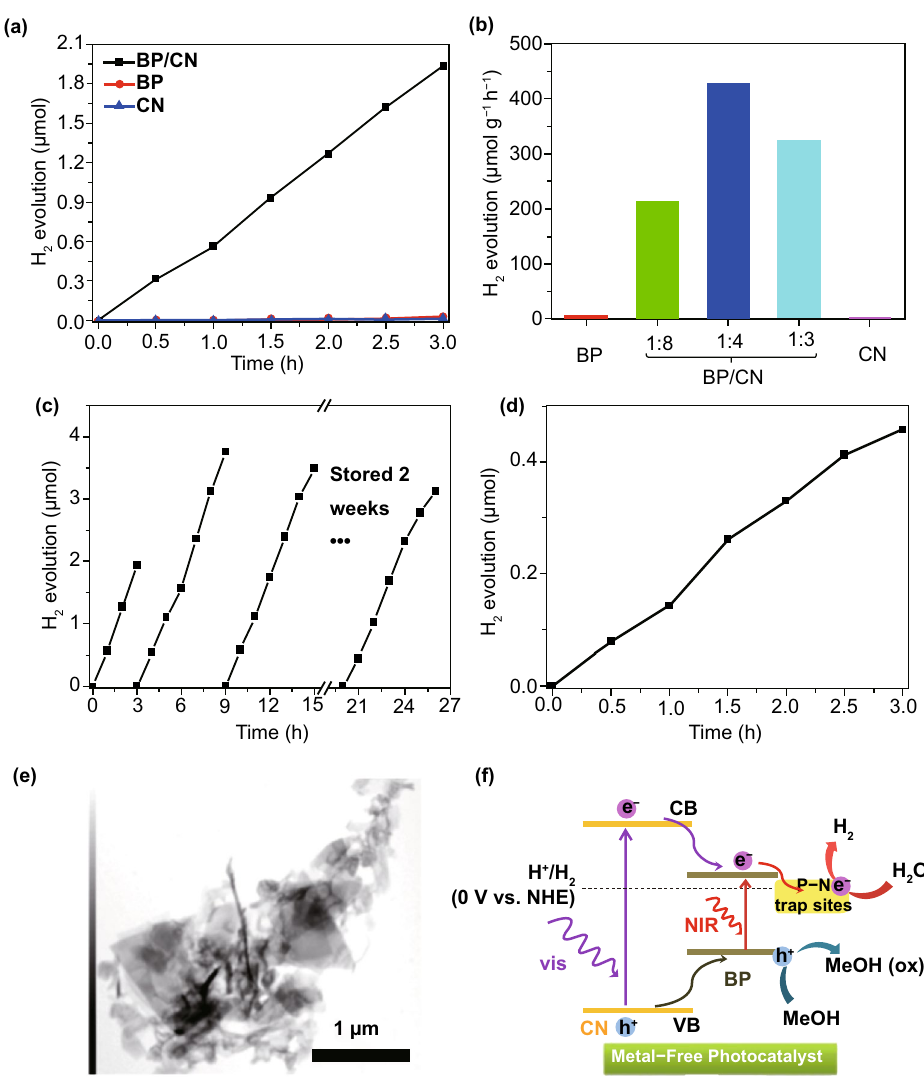
Fig. 25 a Photo‑catalytic H 2 evolution based on different catalysts with > 420 nm. b Effect of BP/CN ratio in BP/CN on photo‑catalytic H 2 pro‑ duction rate under vis‑light irradiation for 3 h. c Cycle stability test on BP/CN photo‑catalytic H 2 production under vis‑light irradiation. d Photo‑ catalytic H 2 production based on BP/CN with > 780 nm light irradiation. e HAADF‑STEM image. f Scheme for photo‑catalytic H 2 evolution utilizing BP/CN. Adapted with permission from Ref.